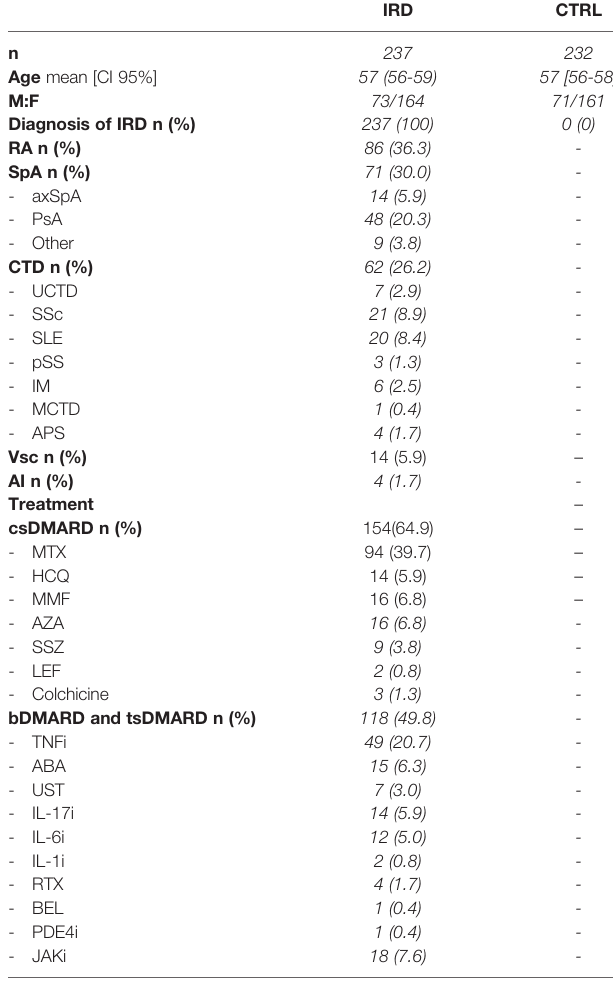
TABLE 1 | Demographic characteristics of patients and